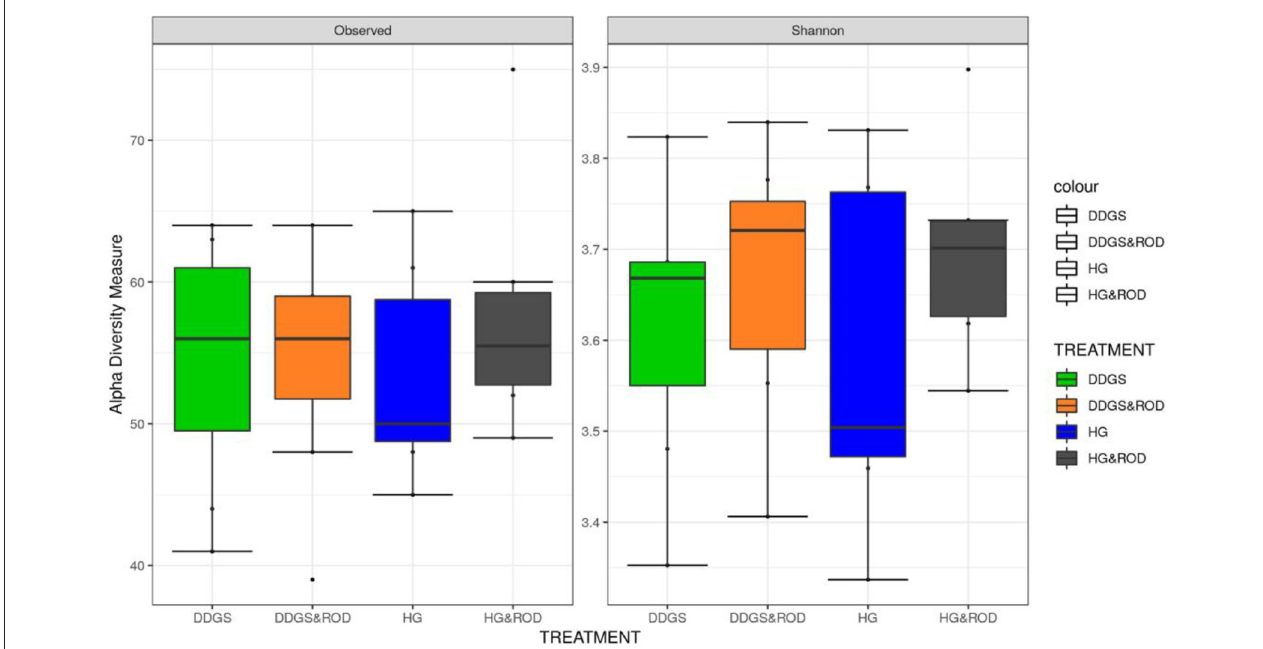
FIGURE 1 | Box plots of the number of operational taxonomic units (OTUs) and the Shannon diversity index for feed particle-associated (FPA) samples by treatment. Treatments were as follows: wheat dried distillers grains with solubles (DDGS) diet without adding red osier dogwood (ROD) extract; DDGS&ROD (wheat DDGS diet with ROD extract); HG (basal diet without adding ROD extract); and HG&ROD (basal diet with ROD